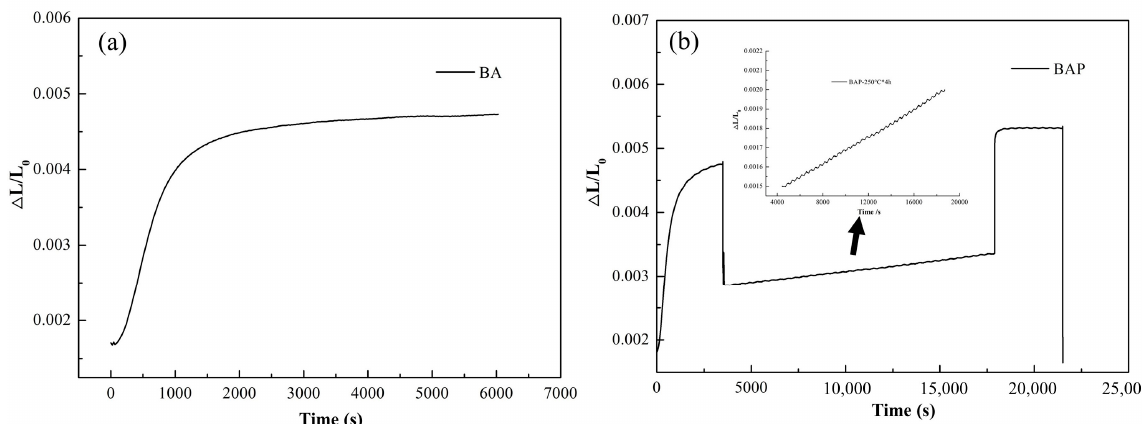
Figure 6. The relative length changes ( Δ L/L 0 ) of dilatometry specimens: ( a ) Δ L/L 0 versus time during austempering at 350 °C for 3 h; ( b ) the overall changes of BAP heat treatments (the magnifying length change is at 250 °C for 4 h).